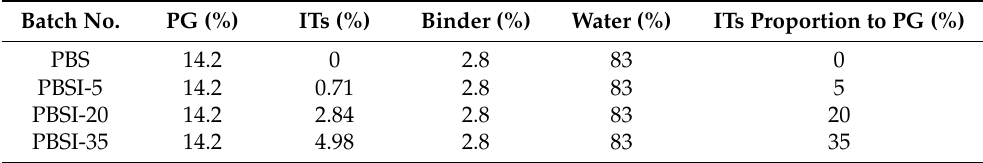
Table 2. Mix proportions of the cement PG backfill slurry.